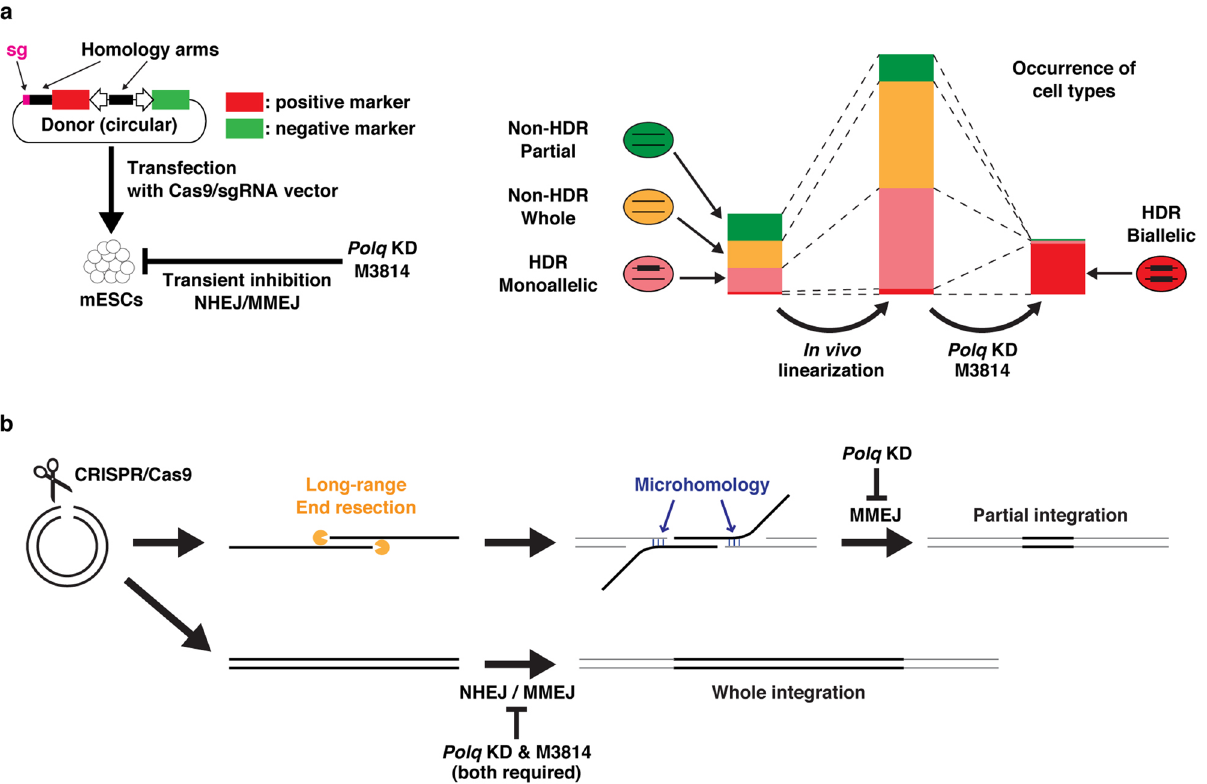
Figure 7. Overview and hypothetical mechanism of biallelic knock-in assisted by Pol θ and DNA–PK inhibition (BiPoD). ( a ) Illustration of BiPoD. The stacked bar graphs indicate the change in the occurrence of each cell type, based on the results of Rosa26a-mCherry knock-in. ( b ) A model of partial integration mediated by long-range end resection. Partial integration is suppressed by Polq knockdown, while the combination of Polq knockdown and M3814 treatment is required for suppression of whole integration (all or almost all regions of the donor isolation. Furthermore, BiPoD achieved simultaneous biallelic knock-in at two different loci. In this study, only one marker gene ( BS r ) was used for selection of stably integrated cells. Consequently, 26% of selected cells were double-biallelic. Thus, double-biallelic knock-in mESCs can be established easily and quickly by BiPoD using only one selectable marker. The increased biallelic knock-in efficiency is likely to result from inhibition of both NHEJ and MMEJ pathways. Generally, NHEJ/MMEJ repairs CRISPR/Cas9-induced DSB sites faster than HDR and causes indel mutations or insertion of donor. Such sites are no longer targeted by CRISPR/Cas9 and subsequent HDR. Indeed, the non-knock-in alleles had indel mutations at the CRISPR target sites in all of the monoallelic knock-in clones generated by the control conditions, indicating that these mutations prevented HDR-mediated knock-in. However, DSB sites have to be repaired by HDR using foreign donors or undamaged chromosomes as templates when both NHEJ/MMEJ are inactivated, although sites repaired using undamaged chromosomes recover their original genomic sequence and can, therefore, be cleaved by CRISPR/Cas9 again. Consequently, all target alleles are eventually cleaved and repaired by HDR using donor DNAs, resulting in biallelic knock-in or apoptosis. During the knock-in experiments, several types of partial integration were observed. Knock-in into Rosa26a generated a minor population of cells that only expressed a negative selection marker (R−G+) (Fig. 2). Simulta- neous knock-in into Rosa26a and Sox2 generated some clones that harbored randomly integrated Sox2 donors, but that did not express the negative expression marker (Fig. 5b). Such partial integrations create false-positives and prevent rapid acquisition of desired cell lines. These results also indicate that a similar amount of silent integration, which is undetectable by marker expression, occurs concomitantly and silently disrupts the genome. Knock-in into Rosa26a showed that in vivo-linearization did not increase the percentage of R−G+ cells, which decreased the chance of obtaining cells harboring partial integrations. Furthermore, functional inhibition of Pol θ significantly decreased partial integration, and Polq knockdown combined with M3814 treatment abolished almost all partial integrations. Therefore, BiPoD facilitates and accelerates successful acquisition of scarless knock-in cells by excluding partial integrations. Why Polq knockdown decreases partial integration (R−G+) but not integration of all or almost all regions (R+G+) of the donor DNA in the Rosa26a knock-in experiments is an open question. The mechanism underly- ing integration of only the inner part of the donor DNA, i.e., exclusion of the outer regions, is also unclear. One possible hypothesis is that partial integration depends on long-range end resection of the donor DNA followed by MMEJ. MMEJ is initialized with 5 ′ to 3 ′ resection at the ends of DSBs to generate 3 ′ single-stranded tails, and